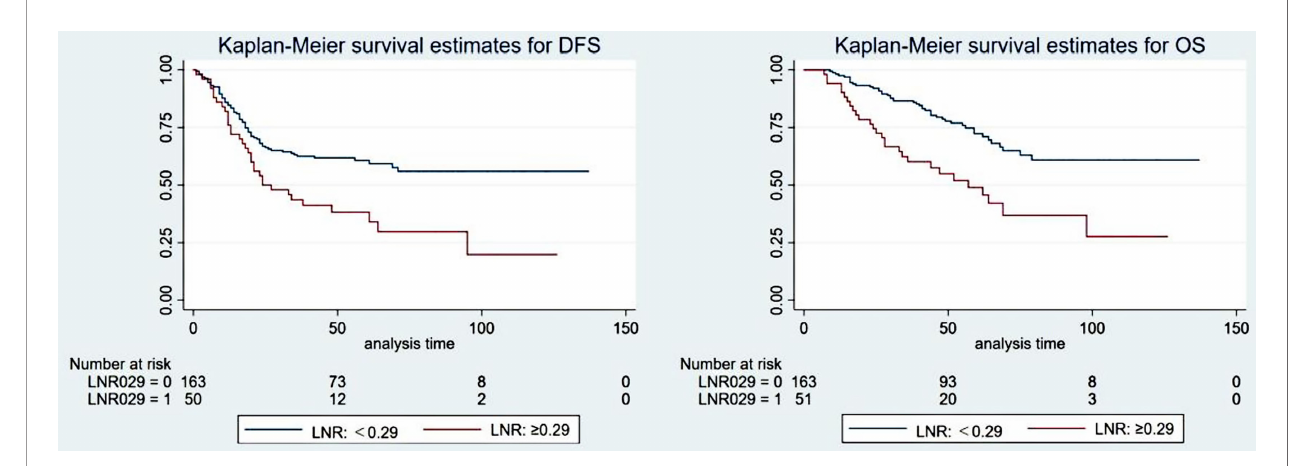
FIGURE 4 | The survival curve of the ypT1-4N+ group when the optimal cutoff value of the positive lymph node ratio (LNR) was